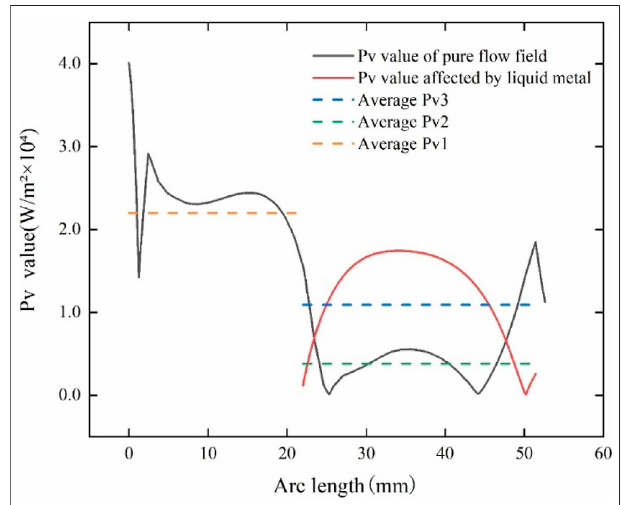
FIGURE 10 | Comparison of Pv values under different